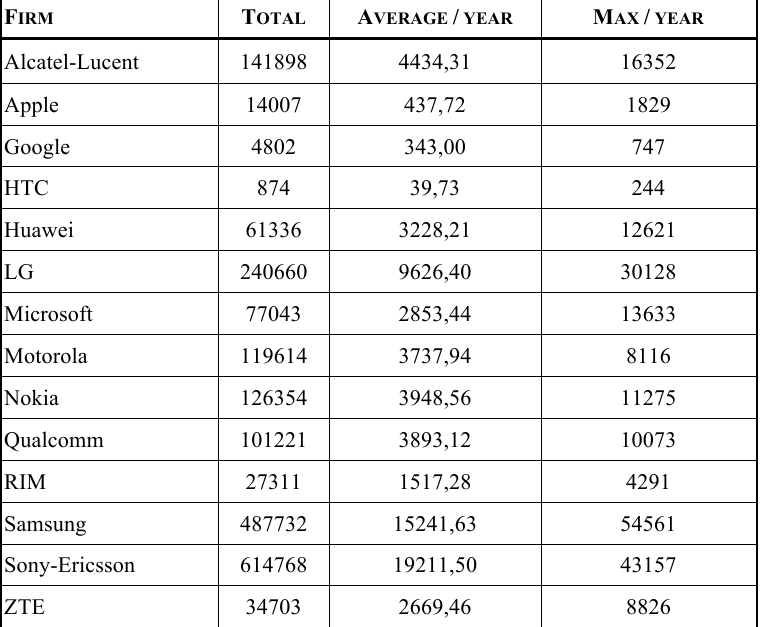
Table 2 . Descriptive statistics from data F IRM T